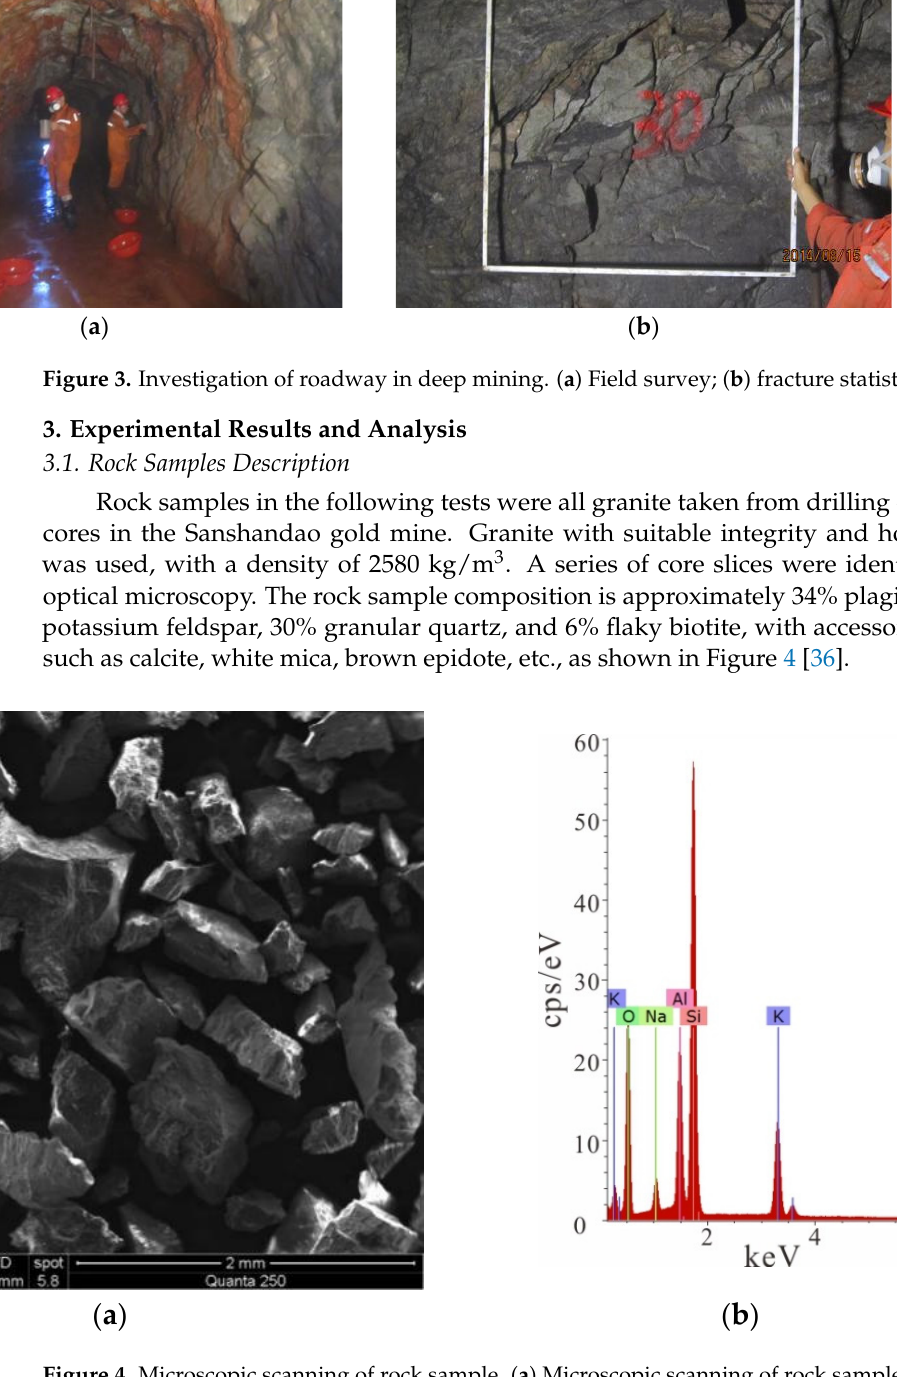
Figure 4. Microscopic scanning of rock sample. ( a ) Microscopic scanning of rock sample; ( b ) element content characteristics of rock sample.